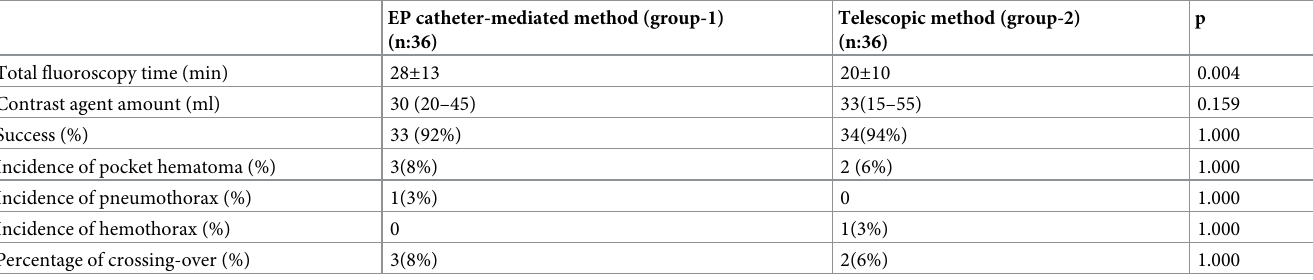
Data are presented as mean ± SD, number and percentage, or median (min-max) and range. P (cid:20) 0.05 was considered statistically